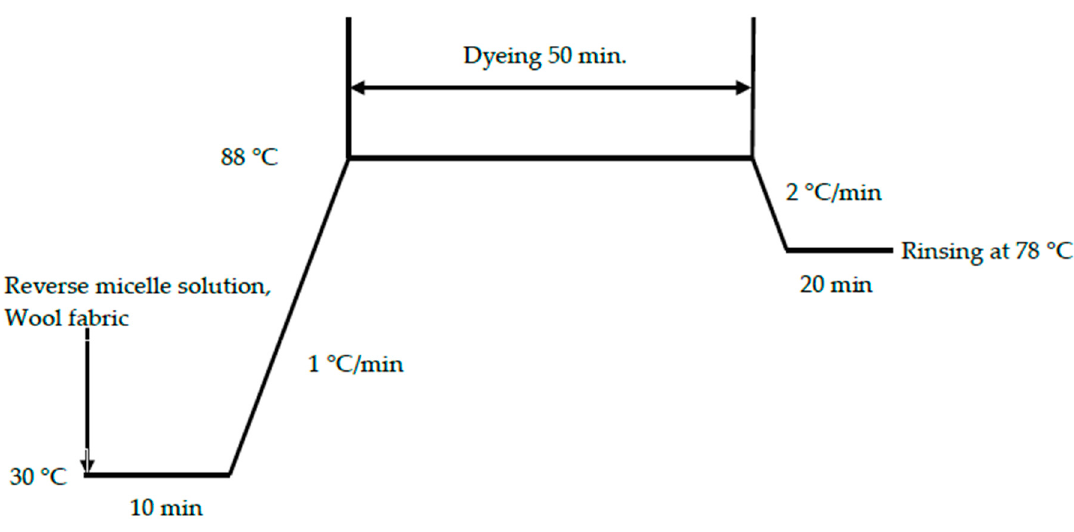
Figure 2. Profile of the reverse-micelle dyeing approach in octane and nonane without salt.